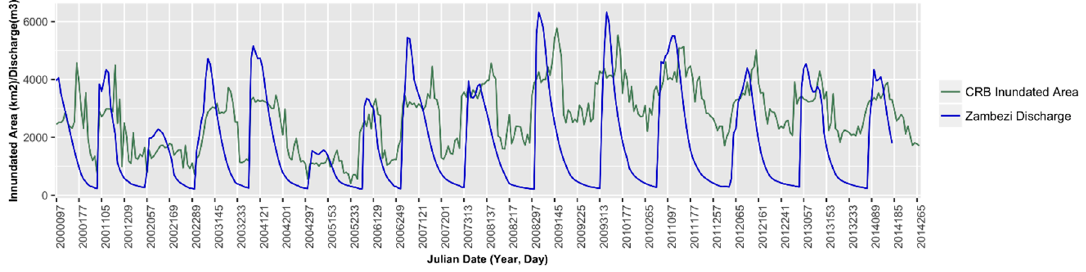
Figure 15. Daily discharge of the Zambezi and derived area of flooding in the Chobe River Basin from 2000 to 2014.